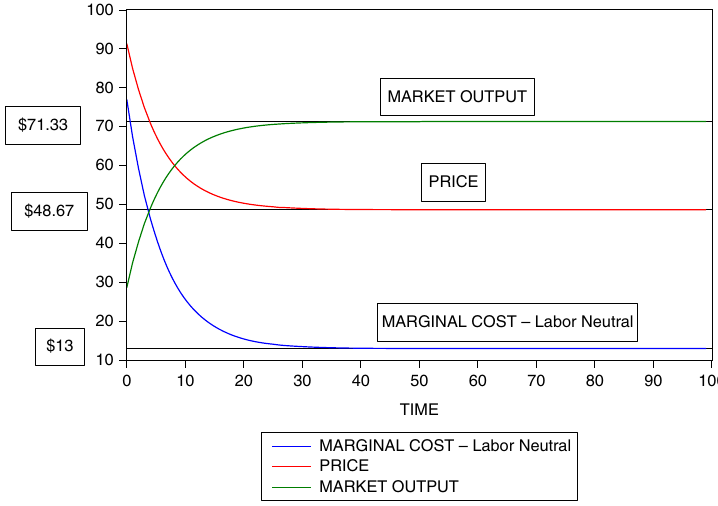
Figure 1. The market outcomes in the long run: labor- neutral